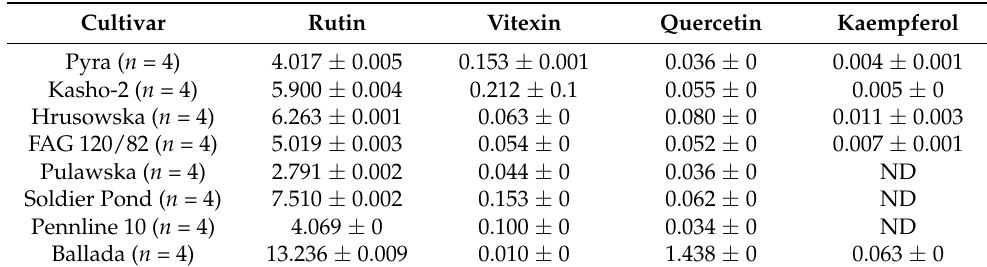
Table 6. Content of flavonoids in grain of investigated buckwheat cultivars (mg/g d.w., means ± standard deviations of four independent determinations). Rutin Vitexin Quercetin Kaempferol Pyra ( n = 4) 4.017 ± 0.005 0.153 ± 0.001 0.036 ± 0 0.004 ± 0.001 Kasho-2 ( n = 4) 5.900 ± 0.004 0.212 ± 0.1 0.055 ± 0 0.005 ± 0 Hrusowska ( n = 4) 6.263 ± 0.001 0.063 ± 0 0.080 ± 0 0.011 ± 0.003 Pulawska ( n = 4) 2.791 ± 0.002 0.044 ± 0 0.036 ± 0 ND Soldier Pond ( n = 4) 7.510 ± 0.002 0.153 ± 0 0.062 ± 0 ND Pennline 10 ( n = 4) 4.069 ± 0 0.100 ± 0 0.034 ± 0 13.236 ±